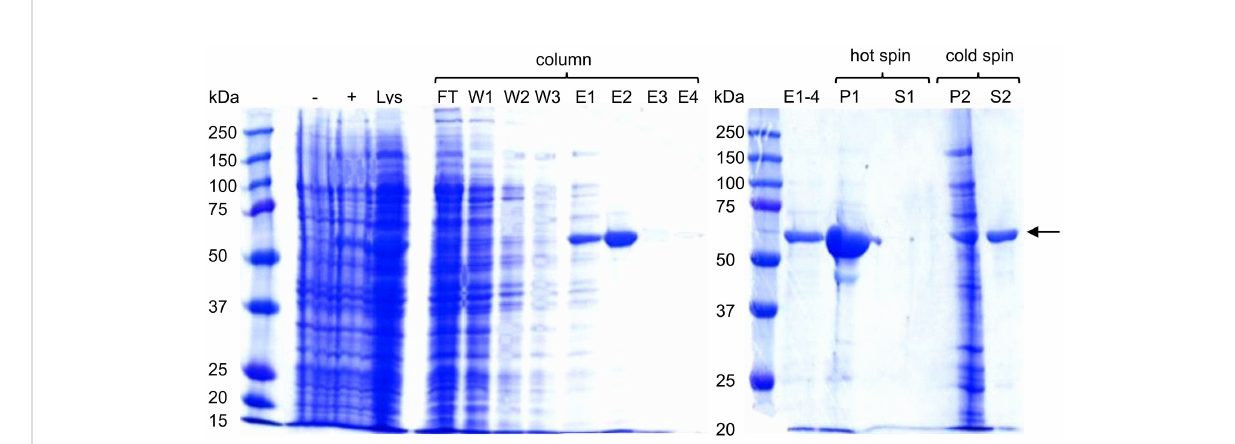
FIGURE 1 Expression and puri fi cation of ELP-Bet v 1. Samples were analyzed on a 10% SDS-PAGE gel using Coomassie Blue staining. ELP-Bet v 1 is clearly visible at about 57 kDa and is indicated with a black arrow. - and + refer to E. coli samples taken before and after induction with IPTG, respectively. Lys is lysate; FT is fl owthrough; W is wash; E is elution; P is pellet; S is supernatant; hot spin is the centrifugation step at 22°C; cold spin is the centrifugation step at